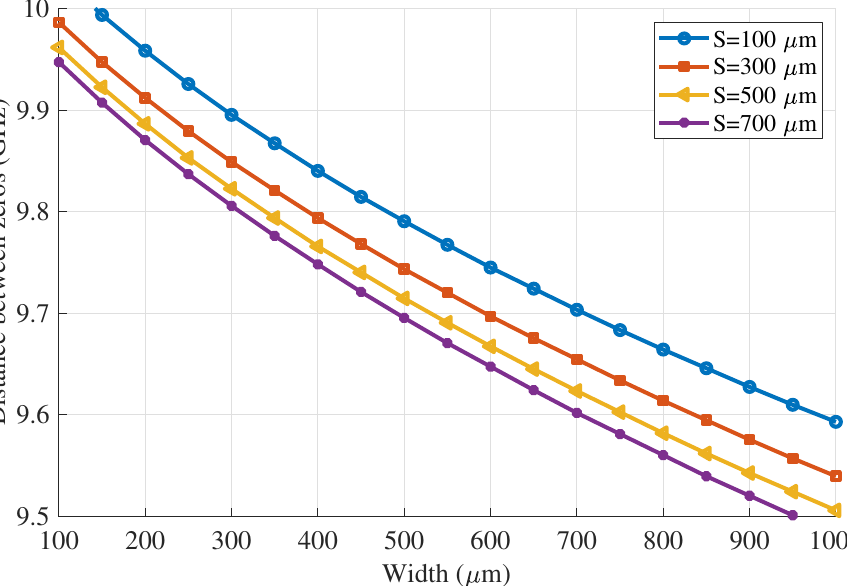
Figure 3. Analytical values of MTL bandwidth for different finger widths ( W ) and separations ( S